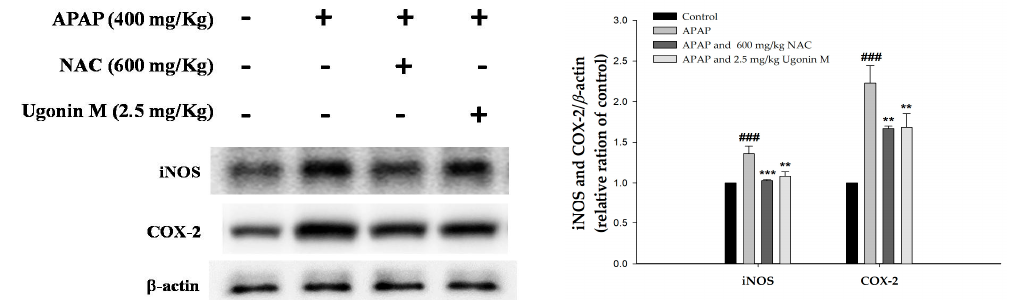
Figure 7. Effects of Ugonin M on inducible nitric oxide synthase (iNOS) and cyclooxygenase-2 (COX-2) protein expression in liver tissue. Data are expressed as M ± SD; n = 3.